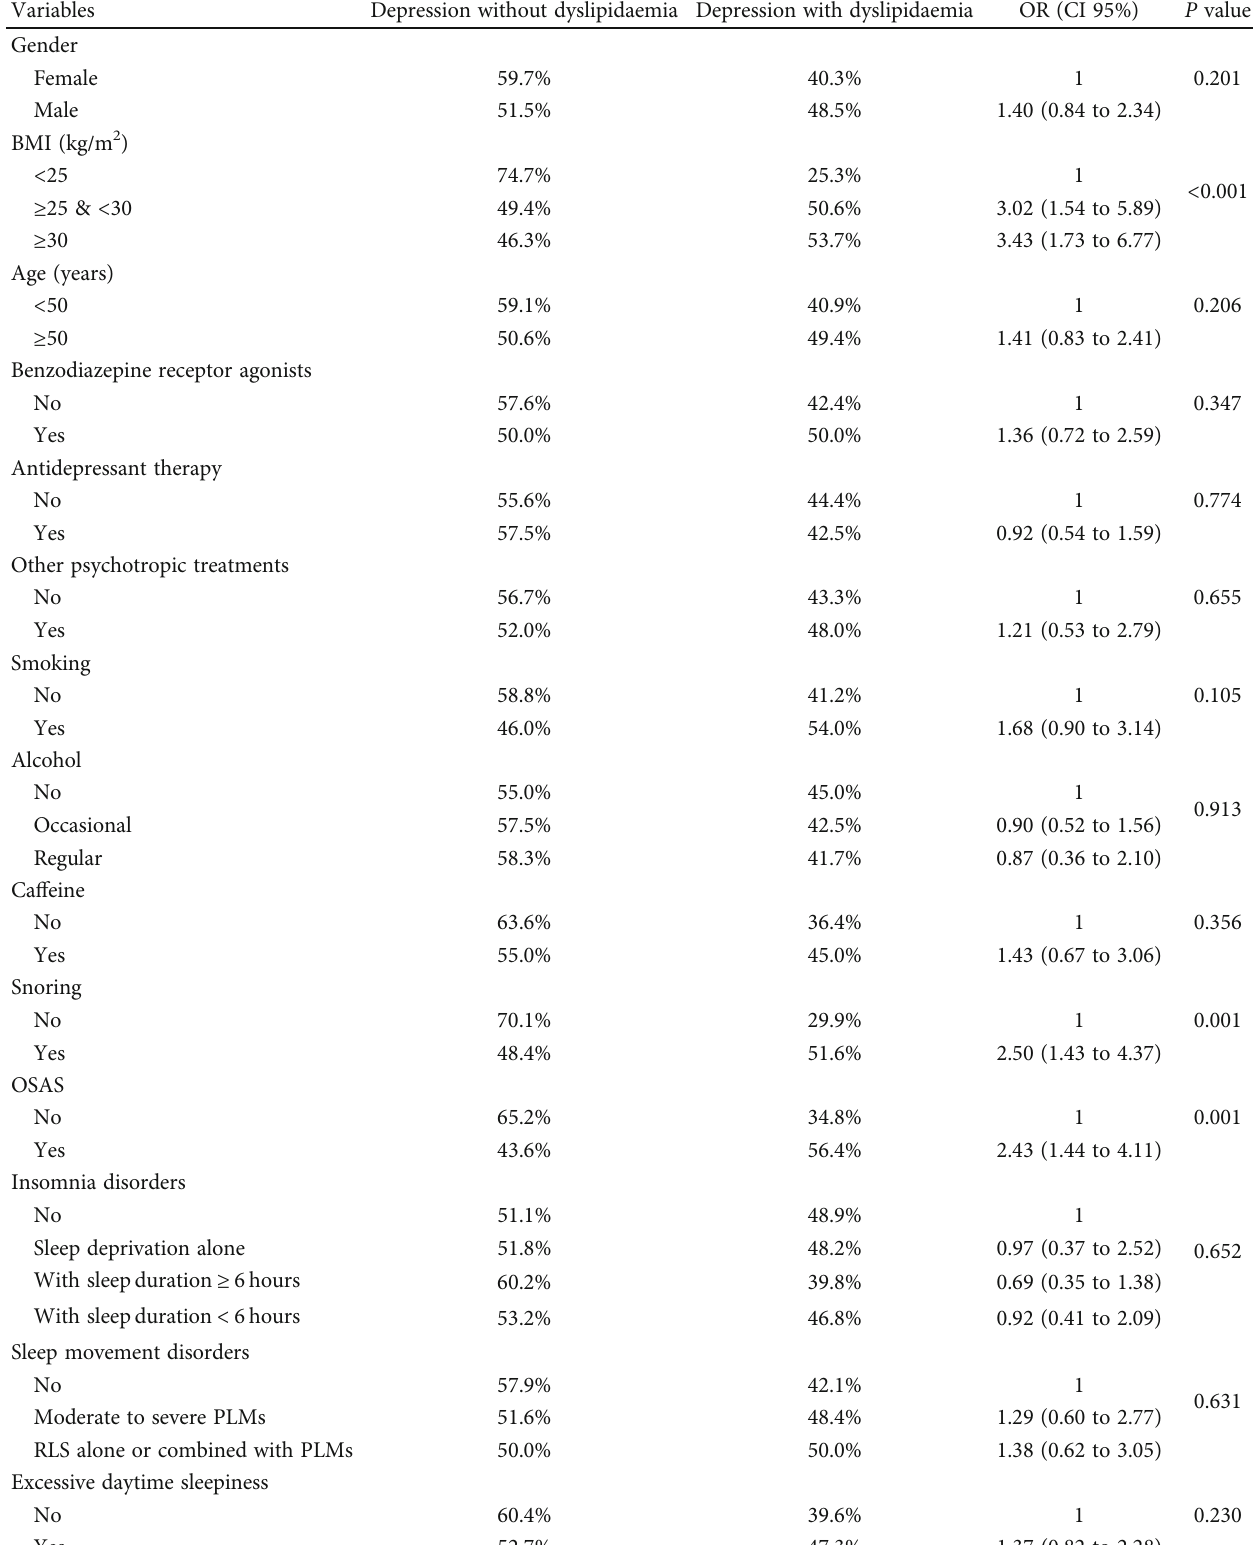
Table 3: Univariate analyses ( n = 242